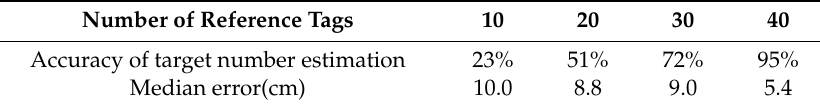
Table 3. The results using di ff erent number of reference tags.